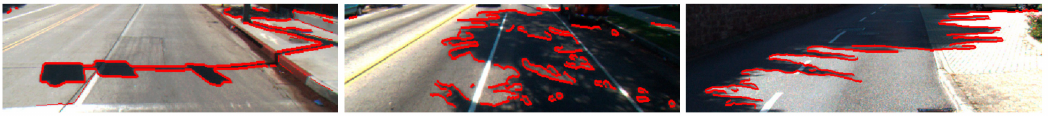
Figure 17. Shadow edge detection results of images in Figure 12 obtained by the proposed